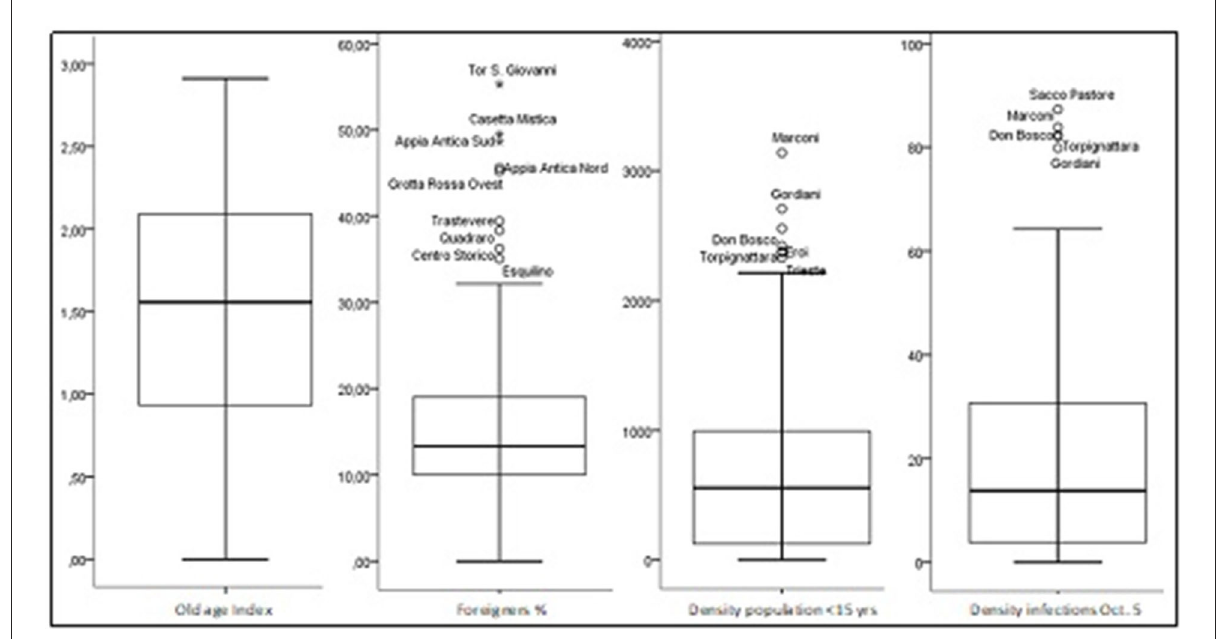
FIGURE3 Characteristics of the territorial distribution of the explanatory